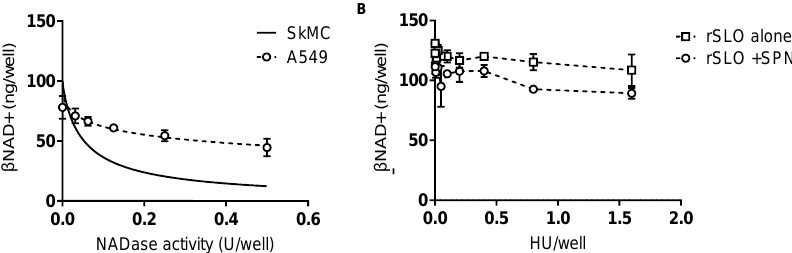
Figure 5. SPN-mediated reduction in intracellular β NAD+ is cell type specific. ( A ) Cultured human epithelial cells (A549s) were exposed to increasing concentrations of SPN, specified in NADase U/well (dotted line). Solid line is for comparison of SkMCs data from Figure 2C. EC50 ± 95% CI = 0.3 ± 0.4 U/well for A549 β NAD+. EC50 for SkMCs is 0.05 ± 0.05 U/well, as reported in Figure 2C. ( B ) A549s were treated with SLO alone or SLO with 0.03U SPN, as done in Figure 3. In all graphs, symbols represent the mean of n = 2 independent experiments. Error bars represent SEM. Linear data not fit.